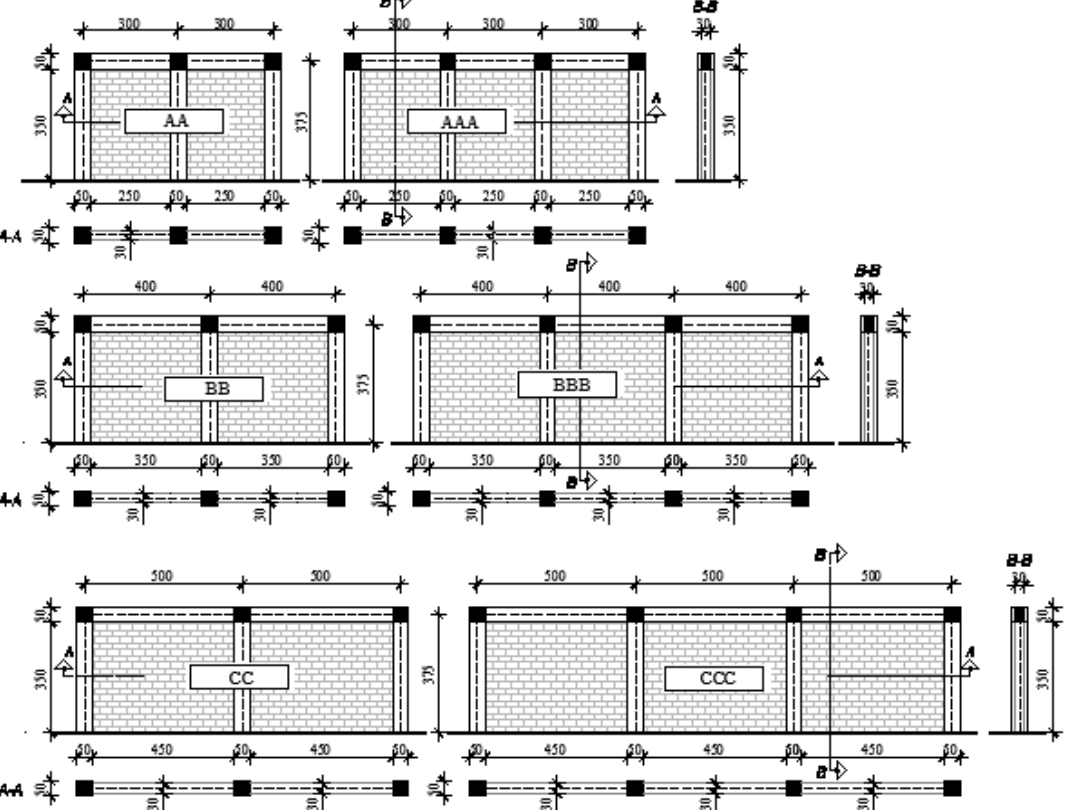
Figure 7. Infilled frame models – multi-bay models with same bay length.